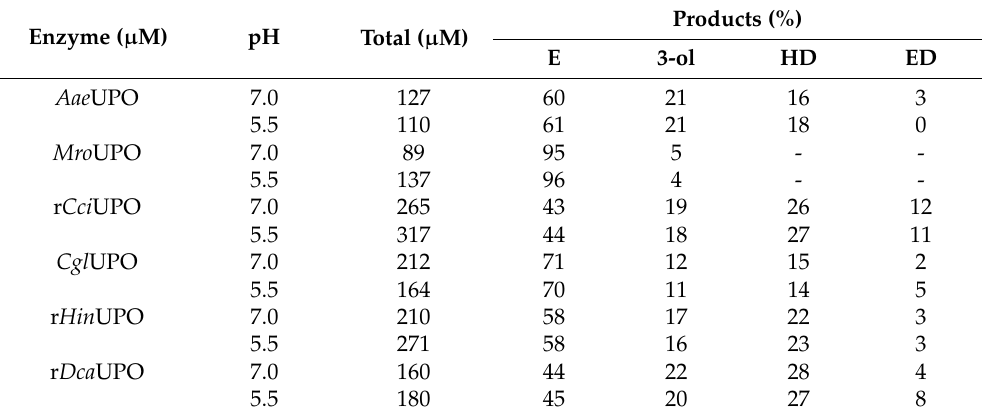
Table 2. Total ( µ M) and relative abundance (%) of products (E, 3-ol, HD, and ED, see Scheme 1) from the reactions (24 h, 60% acetone, 1 mM H 2 O 2 ) of 1-tetradecene (1 mM) with several UPOs (2 µ M) at pH 7.0 or